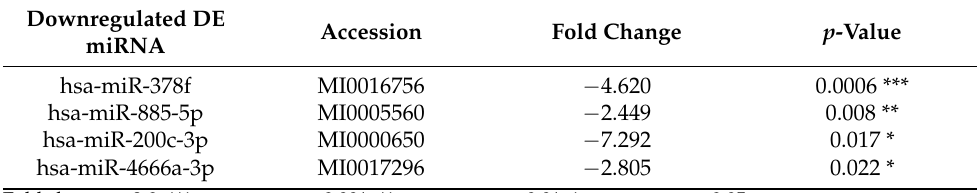
Table 2. List of DE miRNAs in GC patients with XELOX chemotherapy. Downregulated DE Accession Fold Change p -Value miRNA hsa-miR-378f